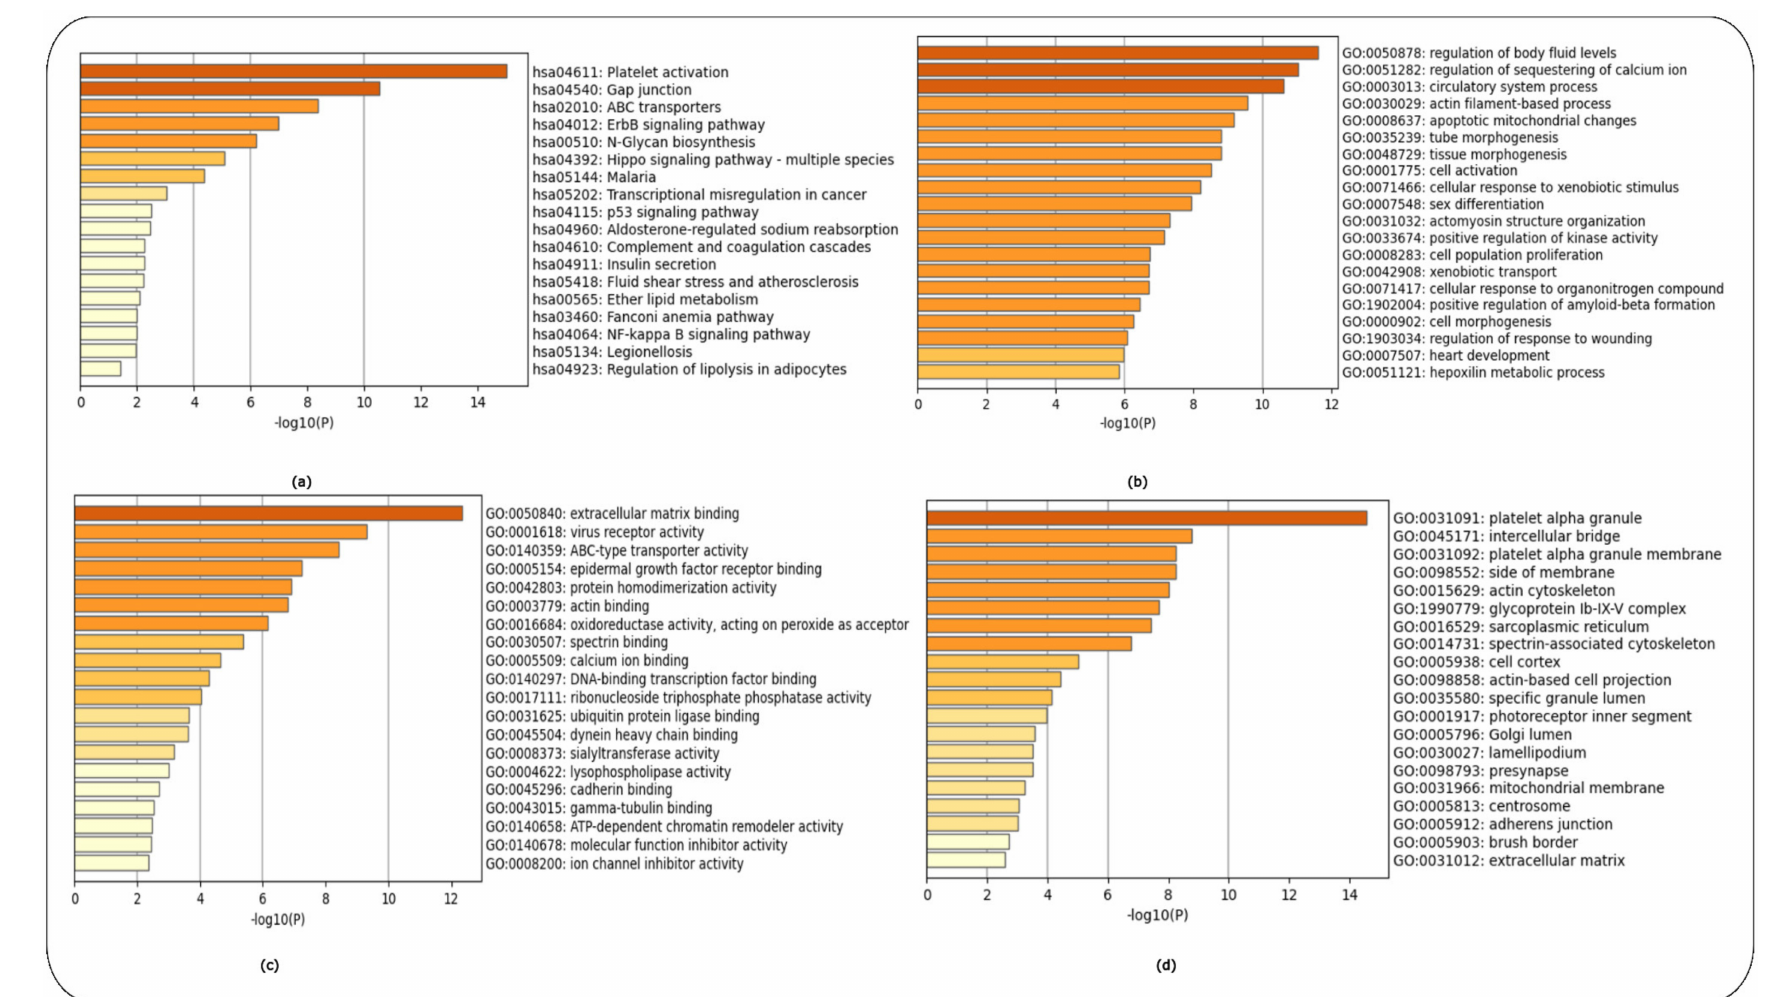
Figure 6. Enrichment analysis of controls versus Stage 1 HD patients (Year 1) using the KEGG and GO libraries in Metascape. ( a ) KEGG pathways, ( b ) GO Biological Process, ( c ) GO Molecular Function and ( d ) GO Cellular